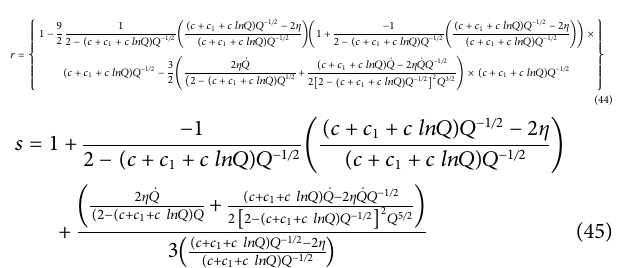
Figure 7 , shows the evolution trajectory for ghost dark energy f ( Q ) gravity model in ( r − s )- plane towards different value of η . From Figure 7 , the evolution trajectories of ( r − s )- plane favors the